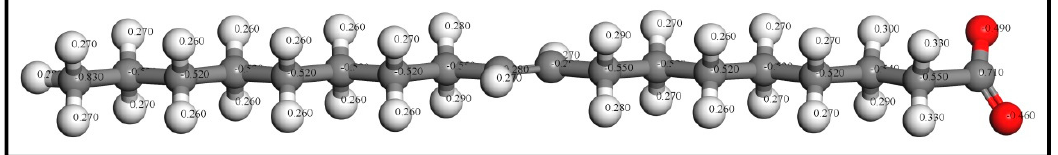
Figure 1. Optimized oleate ion structure with partial Mulliken charges (colour codes: Gray—C, White—H, Red—O).